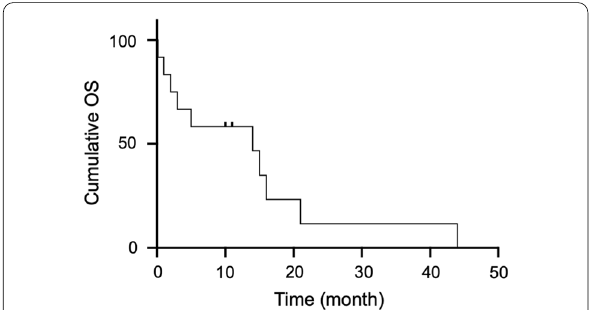
Fig. 8 The Kaplan–Meier curve of OS in patients with